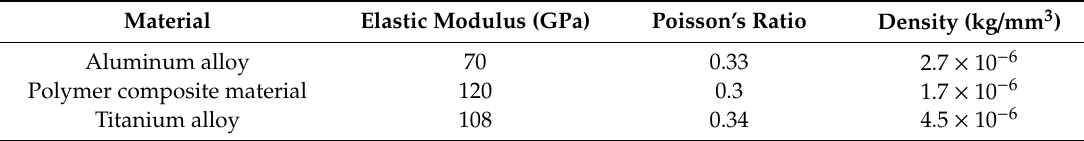
Table 1. Material